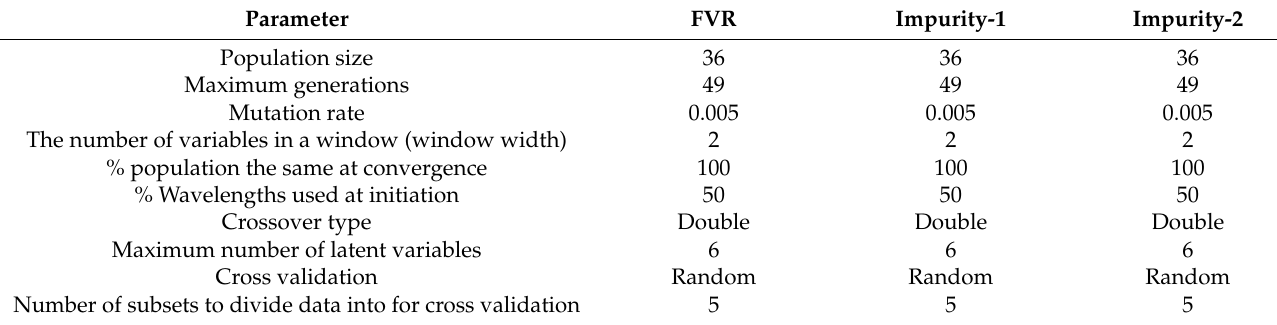
Table 1. The genetic algorithm parameters.